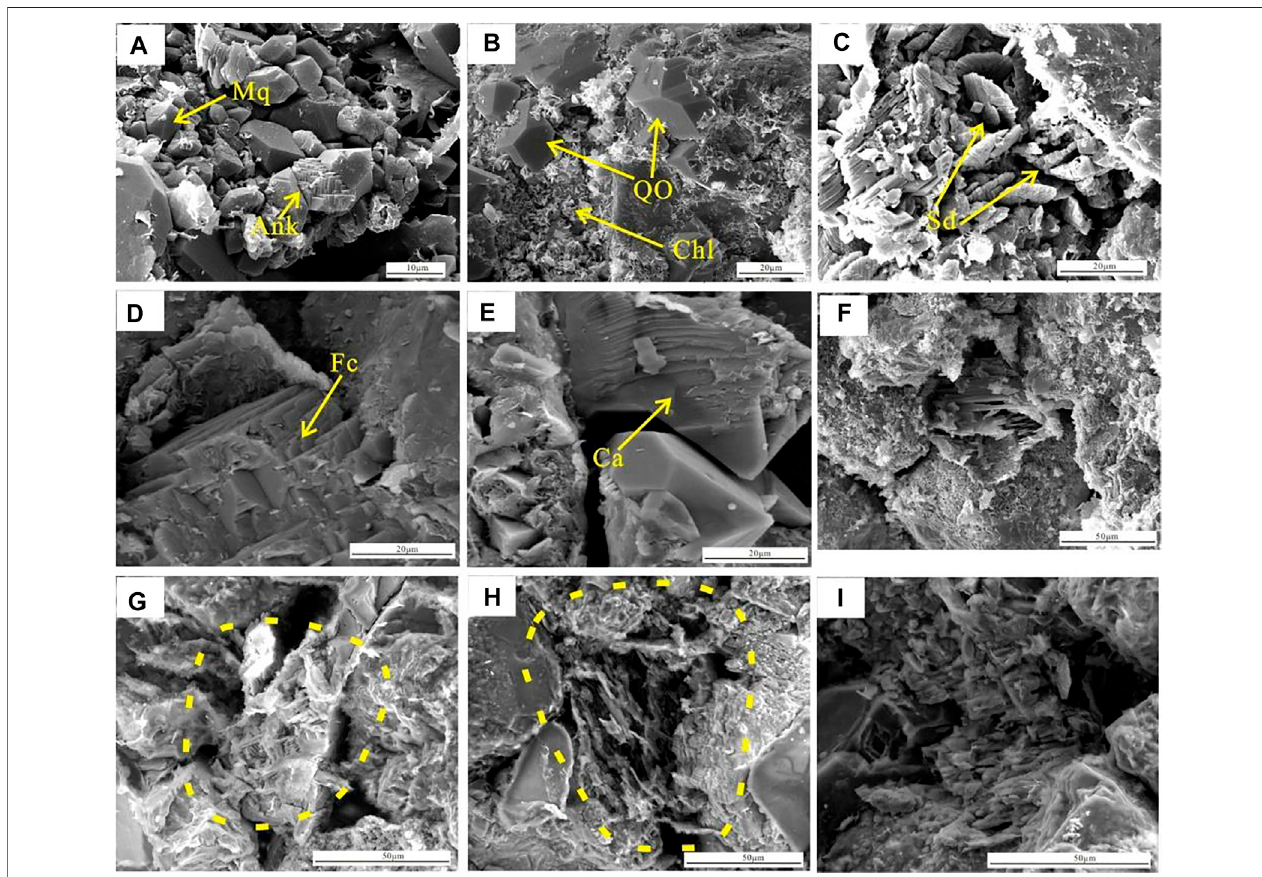
FIGURE6| TypicalSEMphotographsofdiageneticalterationsintheHuangliusandstones. (A) WellAF-1 – 6,2,875.68 m,ankerite(Ank)andmicroquartz(Mq)exist inintergranularpores. (B) WellAF-1 – 12,2,710.46 m,microquartzovergrowthdeveloponquartzgrainwithauthigenicchlorite(Chl). (C) WellAF-1 – 6,2,874.82 m,discus shape siderite (Sd) fi ll in dissolved pores. (D) Well AF-2 – 1, 3,004.12 m, ferrocalcite generate between particles and replace feldspar. (E) Well AF-2 – 1, 2,996.28 m, the intergranular space istaken up bycalcite, and the cementation ispartly corroded. (F) WellAF-1 – 4, 2,869.85 m, feldspar issubjectedto heavy dissolution. (G) Well AF-1 – 2, 2,990.78 m, K-feldspar is dissolved and fi liform illite exsit in pores and throats. (H) Well AF-1 – 3, 2,907.12 m, the feldspar is corroded and complex micropores develop. (I) Well AF-2 – 1, 3,110.38 m, K-feldspar is leached partly.